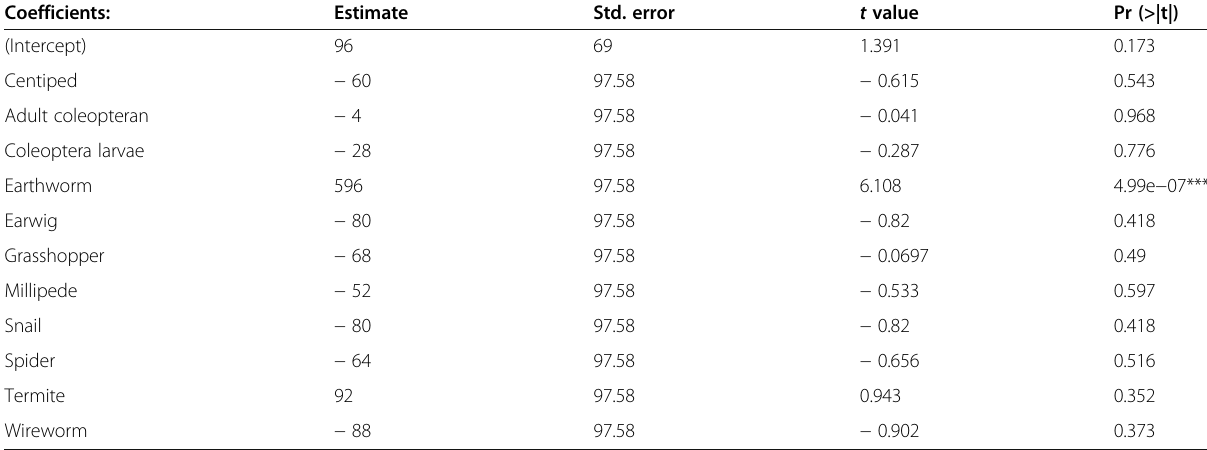
Table 6 Coefficients of linear model